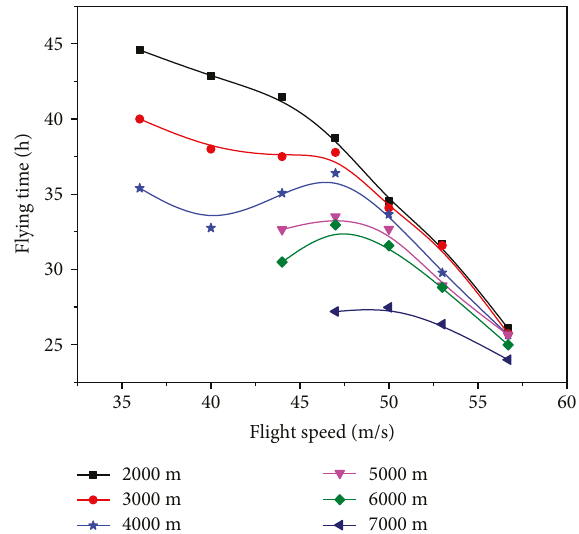
Figure 22: Maximum fl ight time at di ff erent